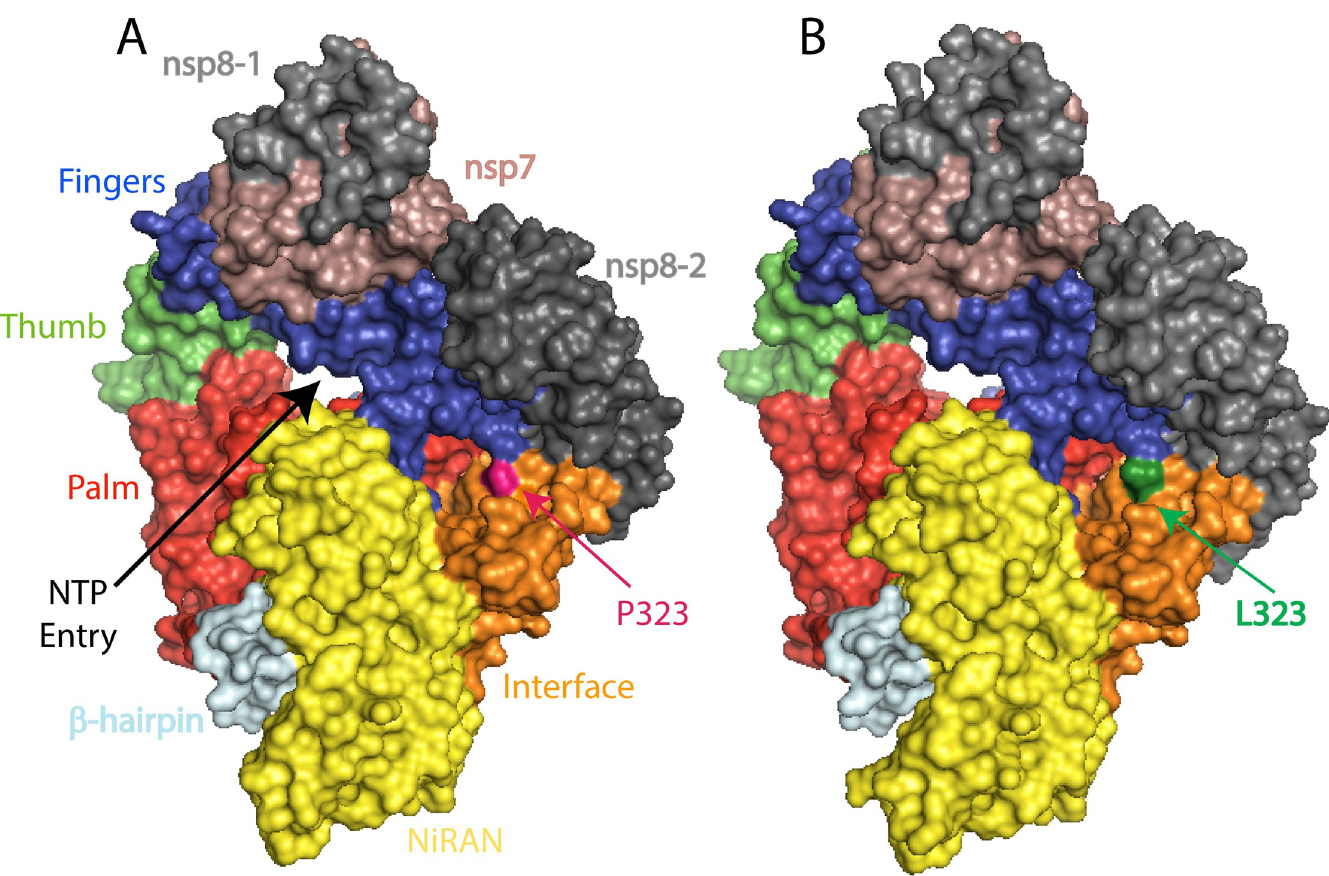
Fig 9. SARS-CoV-2 RNA-dependent RNA polymerase structure in complex with nsp7 and two nsp8. The viral RNA template and NTP entry is shown in black arrow heads. The active site is a large groove with several structural pockets. (A) Wild type RdRp complex P323 is shown in pink (B) L323 mutation is shown in green. RdRp-RNA-dependent RNA